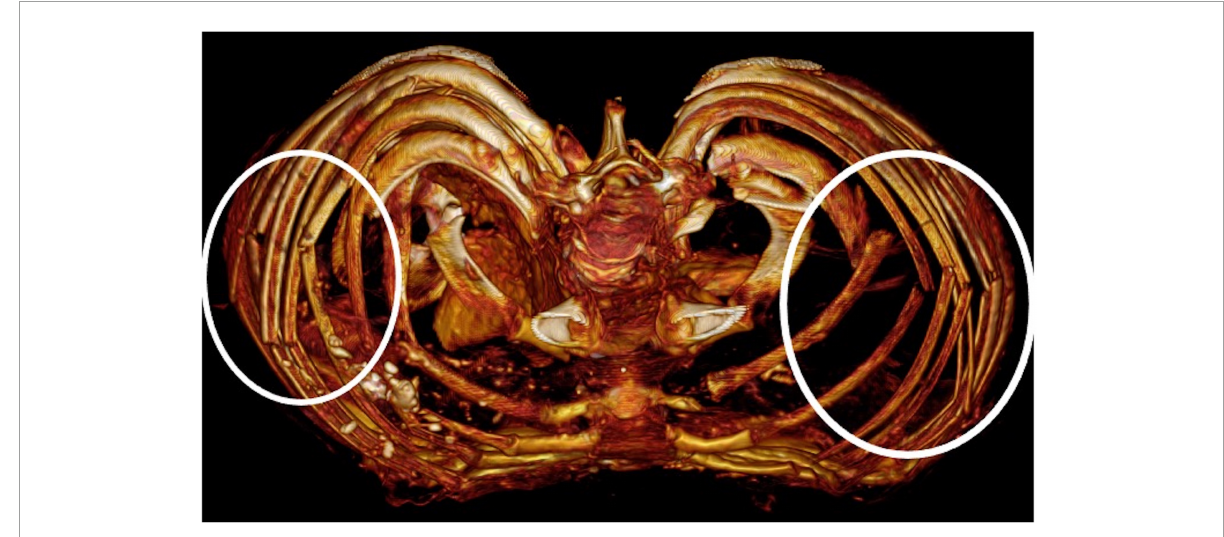
FIGURE14 CT scan reconstruction showing bilateral rib fractures without bony reaction